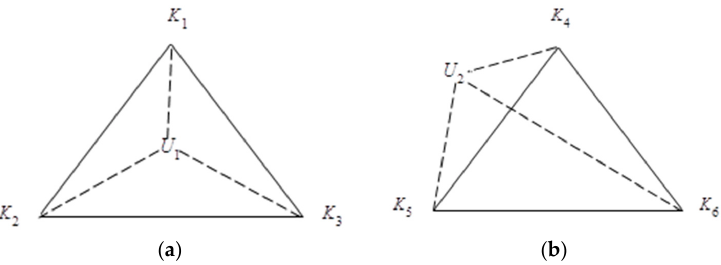
Figure 5. The target node being ( a ) inside and ( b ) outside the triangle area. Figure 4. The target node being ( a ) inside and ( b ) outside the triangle